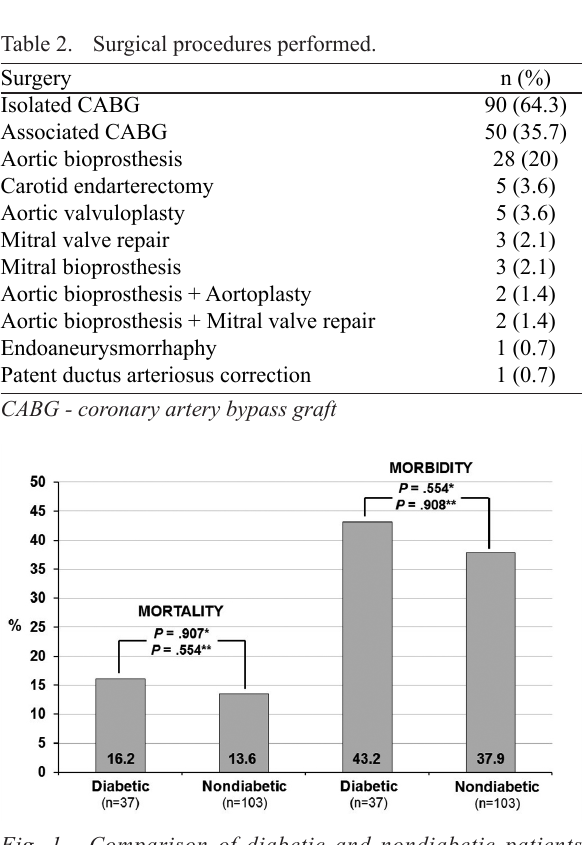
Fig. 1 - Comparison of diabetic and nondiabetic patients regarding to the occurrence of mortality and morbidity